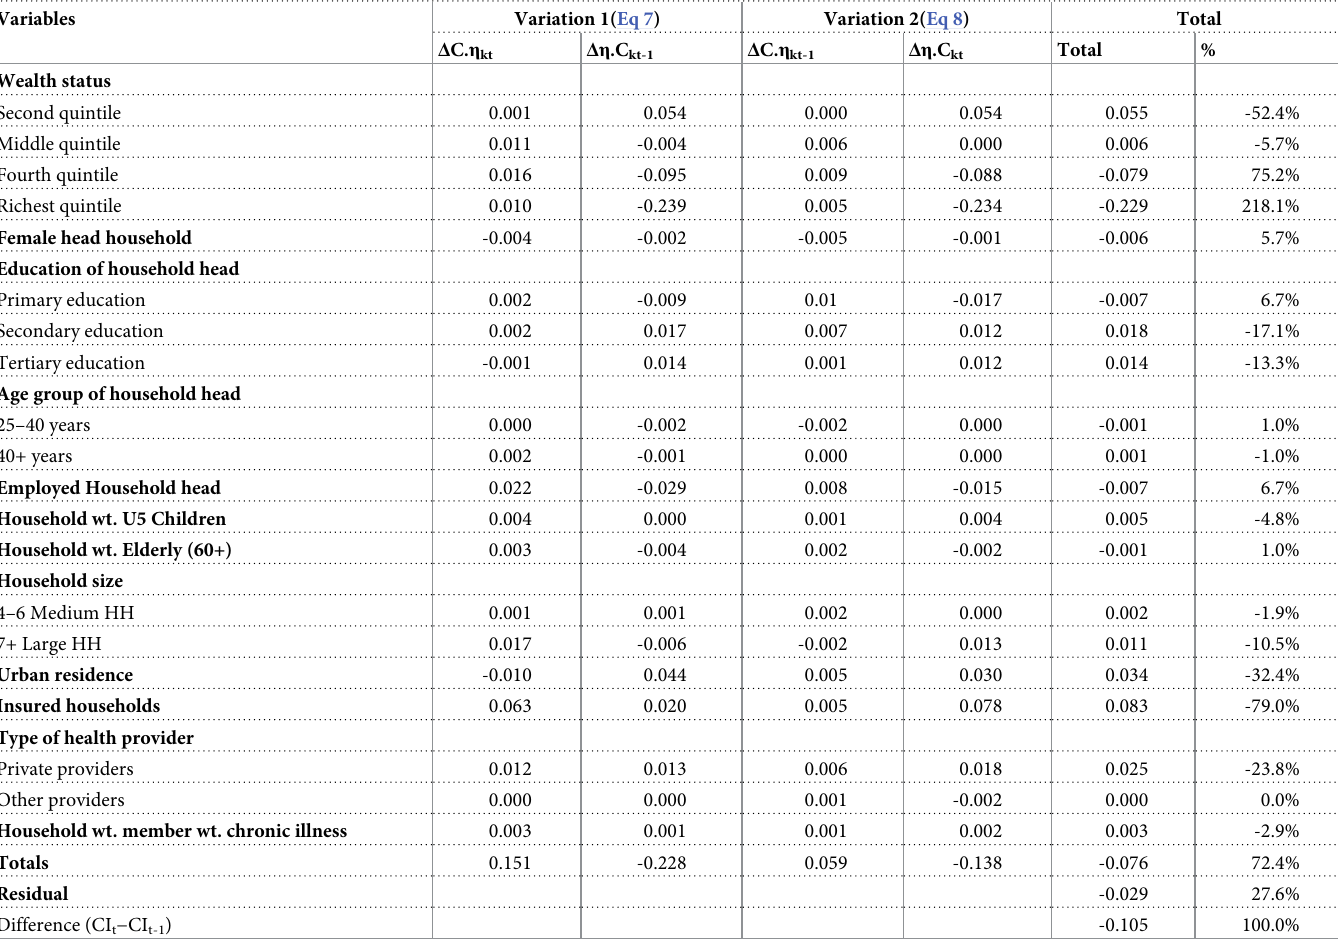
Table 4. Oaxaca-type decomposition of change in inequalities for catastrophic health expenditure, 2007 and